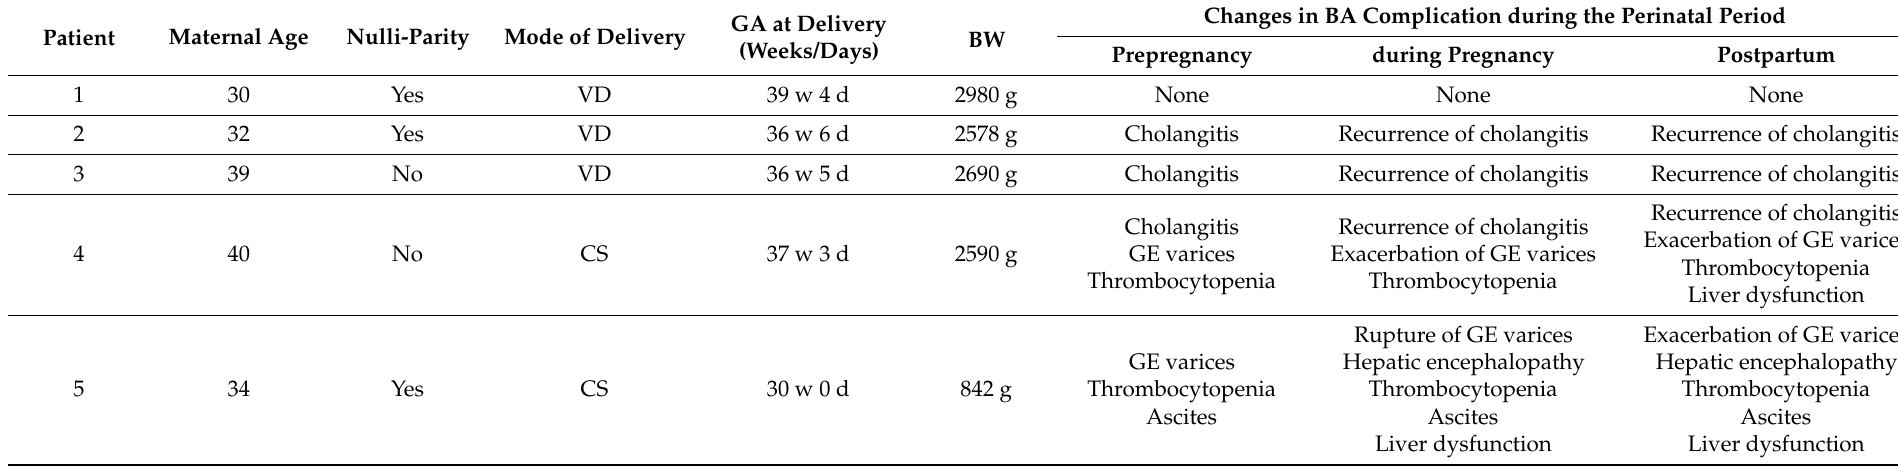
Table 1. Maternal characteristics and perinatal outcomes. LTx, liver transplantation; GA, gestational age; BA, biliary atresia; VD, vaginal delivery; CS, cesarean section; GE varices, gastroesophageal